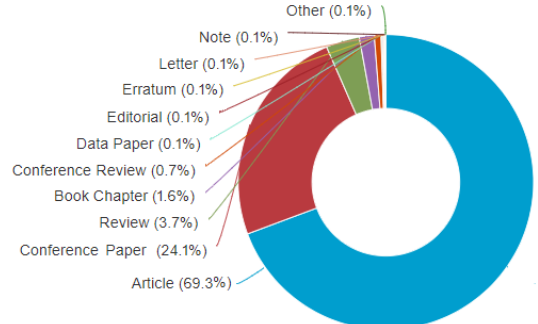
Figure 11. Literature search distribution on the classification of publication type on ‘additive man- ufacturing on lattice structures’, (Scopus database on 20 June